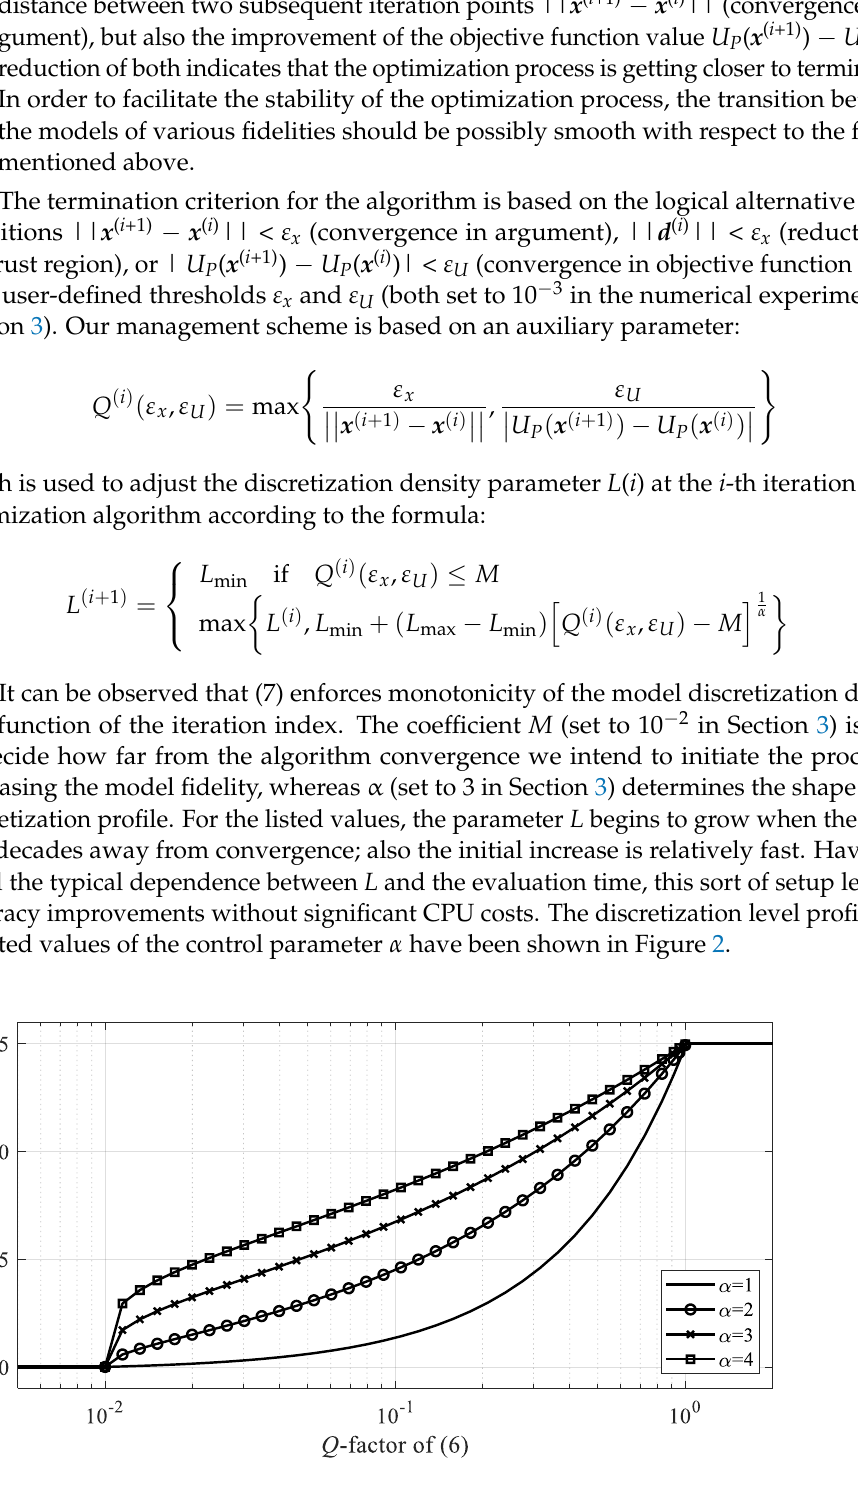
Figure 2. Illustration of discretization level profiles generated by Equation (7), parameterized by the control parameter α . For demonstration purposes, the following setup was used: L min = 10, L max = 25, and M = 10 − 2 .